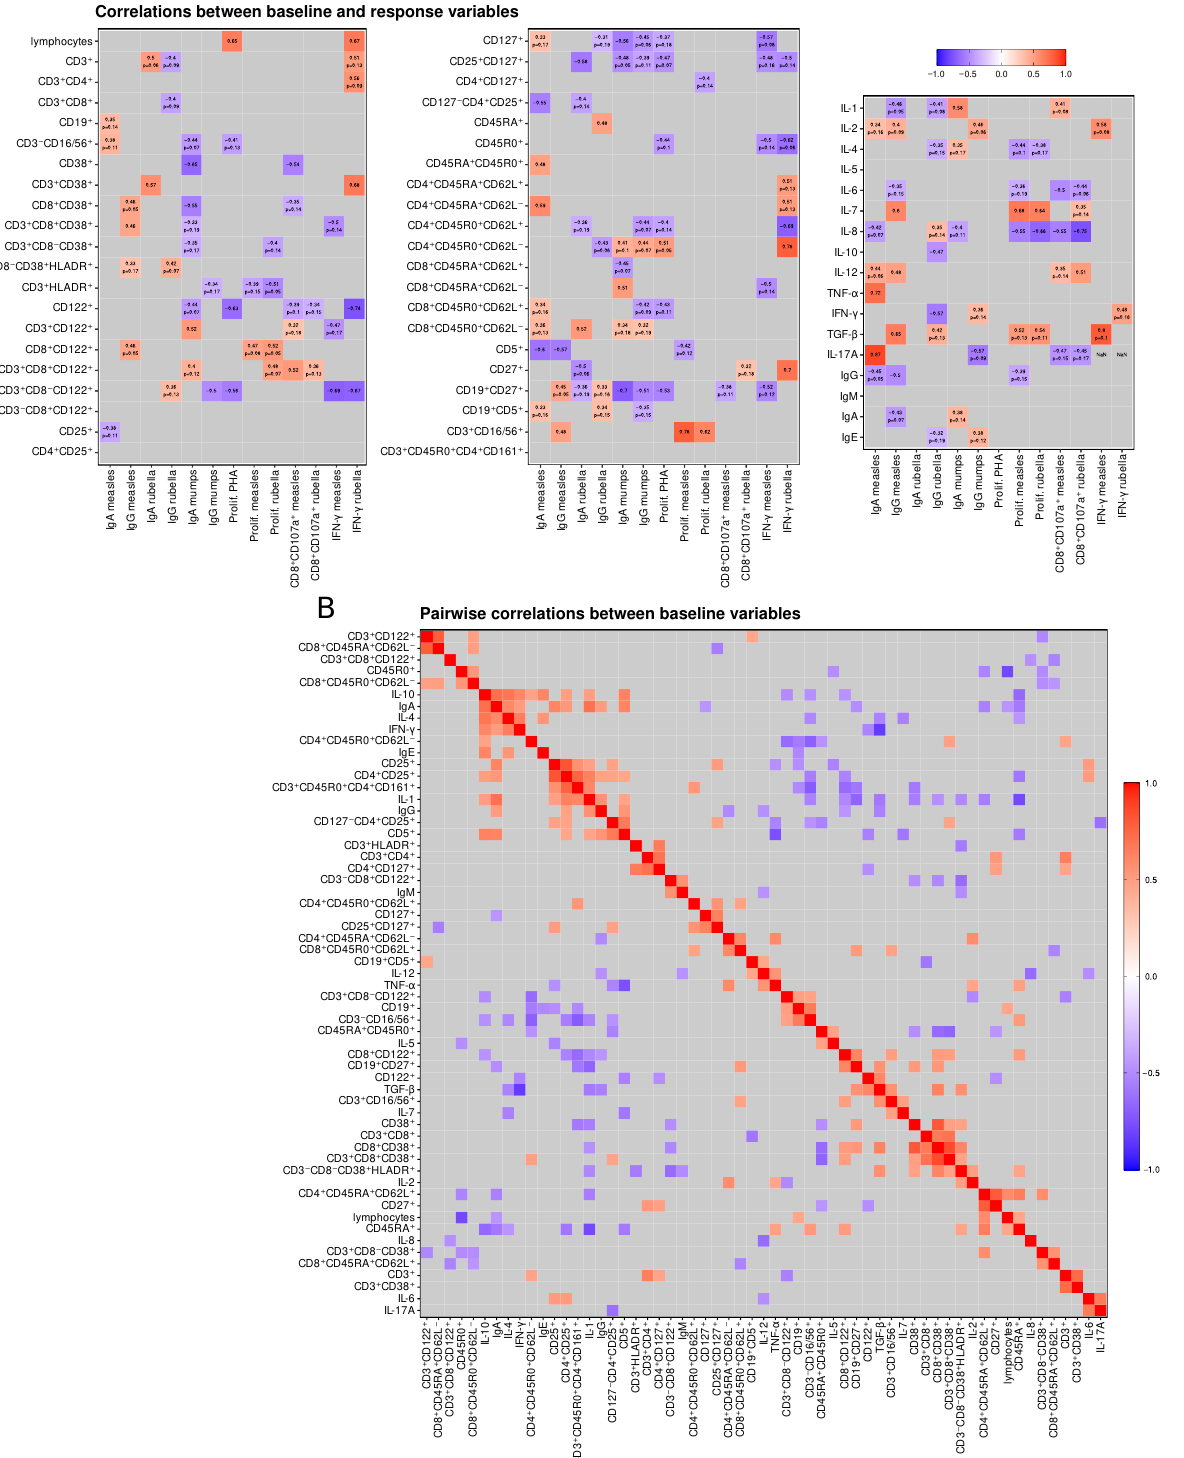
Figure 4. Correlation analysis. ( A ) Correlations between baseline immune status parameters and vaccine-specific immune response variables. Three levels of statistical significance are indicated: significant correlation coefficients ( p < 0.05) are shown, p -values are additionally written for cor- relations with 0.05 ≤ p < 0.2, and correlations with p ≥ 0.2 are marked as gray cells. ( B ) Matrix of pairwise correlations for baseline immune status parameters sorted with hierarchical clustering ordering method. Correlations with significance level p ≥ 0.05 are marked as gray